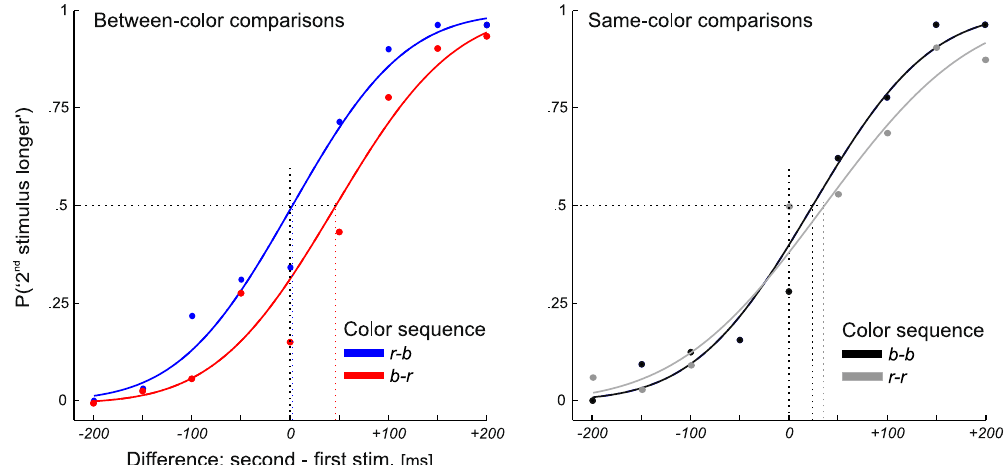
Figure 2. Example psychometric functions for one participant. Left panel: color sequence r-b (blue line) compared to b-r (red line). The line colors represent the hue of the second stimulus. Right panel: color sequence b-b (black line) compared to r-r (gray line). The vertical lines represent the point of objective equality and the points of subjective equality (PSEs). Each psychometric function is based on 288 trials.